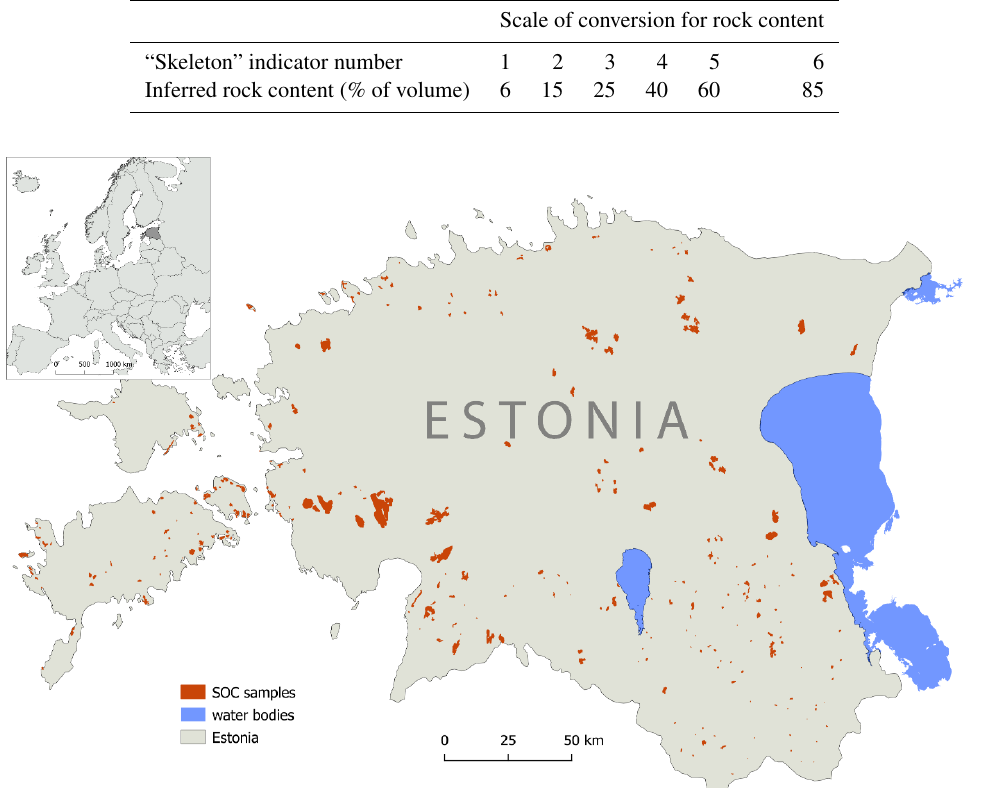
Figure 2. Distinct soil unit polygons including all sampling locations for the machine-learning training